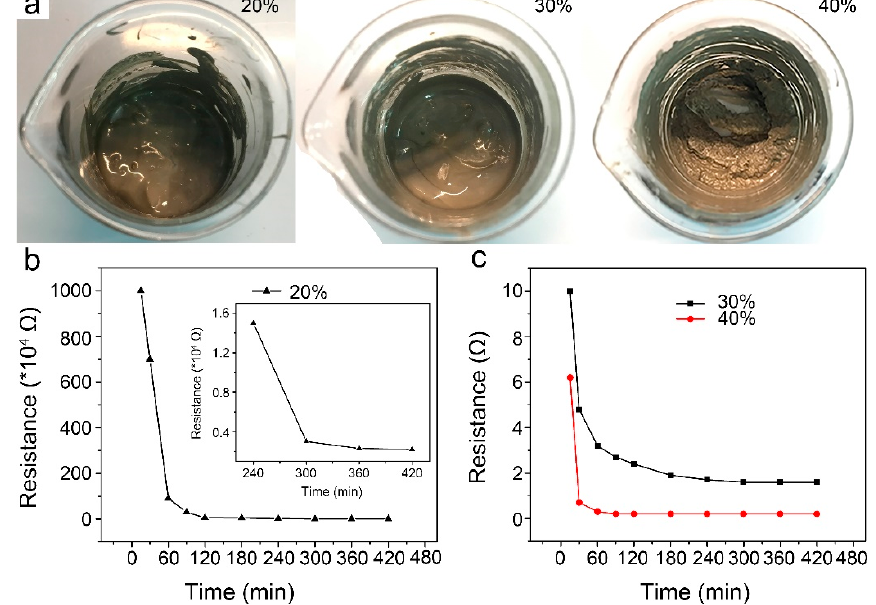
Figure 3. ( a ) Photos of the ECAs filled silver nanowires with 20, 30, and 40 wt% loadings. ( b,c ) The variations in resistance of ECAs filled silver nanowires with different loadings during curing at room temperature for 7 h: ( b ) 20 wt%, ( c ) 30 and 40 wt%. The inset in Figure 3b shows the locally magnified curve.